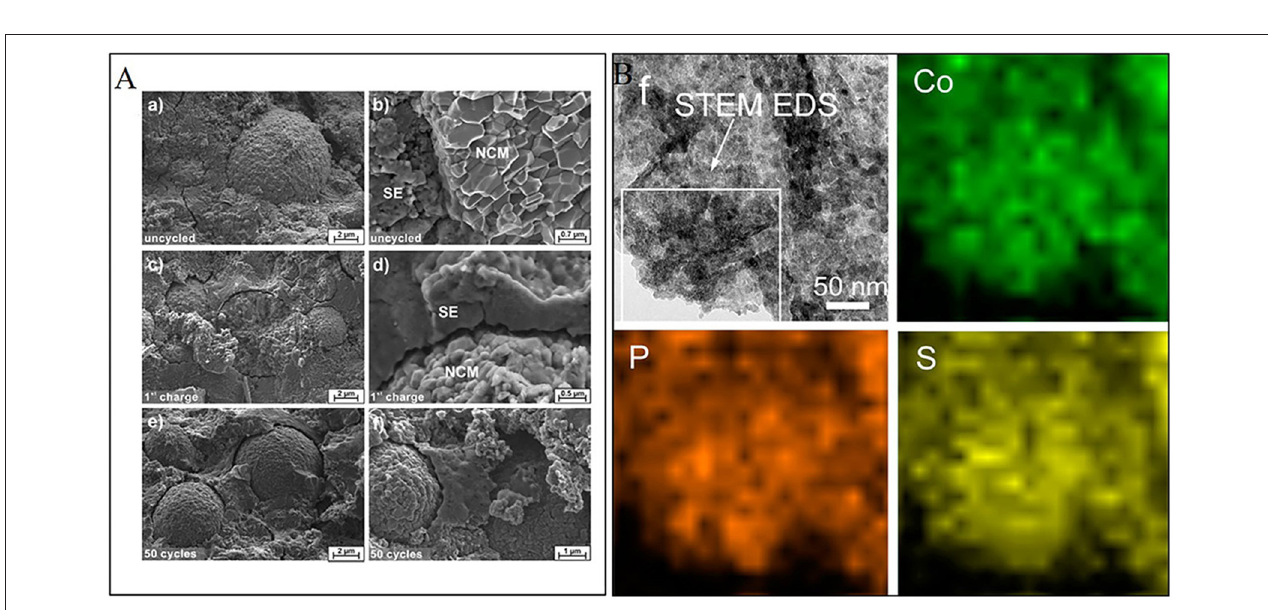
FIGURE 5 | Comparison of atomic structures (at equilibrium state) and Li-ion concentration (at initial stage of charging) at the LiCoO 2 /Li 3 PS 4 interfaces without (left) and with (right) LNbO 3 buffer layer. [Reprinted with permission from ( Haruyama et al., 2014). Copyright (2014) American Chemical Society].